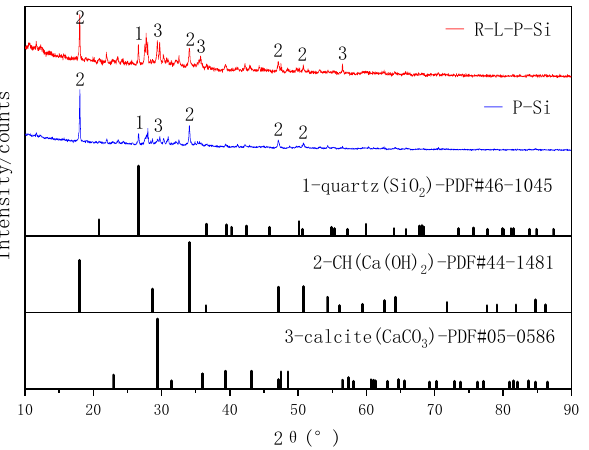
Figure 10. XRD patterns of the reaction product between basalt aggregate and cement materials (1: quartz ((SiO 2 ), 2: CH (Ca(OH) 2 ), 3: calcite (CaCO 3 )). quartz ((SiO 2 ), 2: CH (Ca(OH) 2 ), 3: calcite (CaCO 3